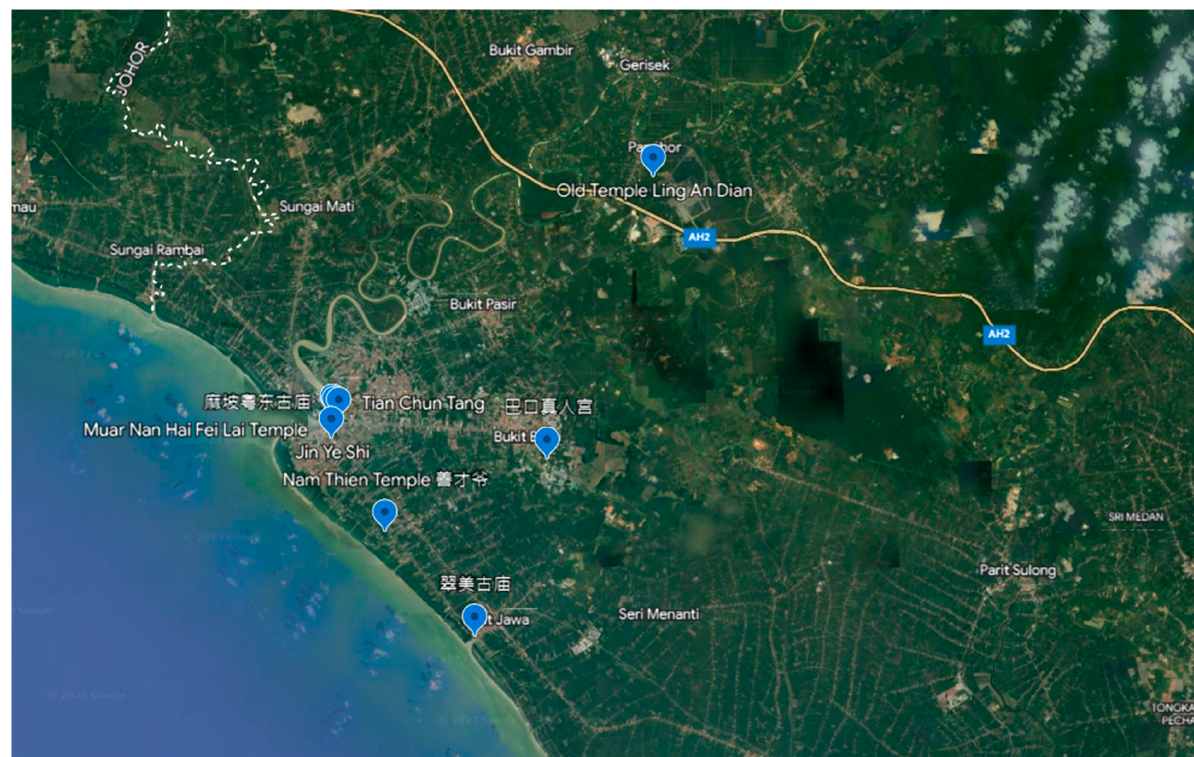
Figure 3. Muar Temples Distribution Map in 1850–1949.